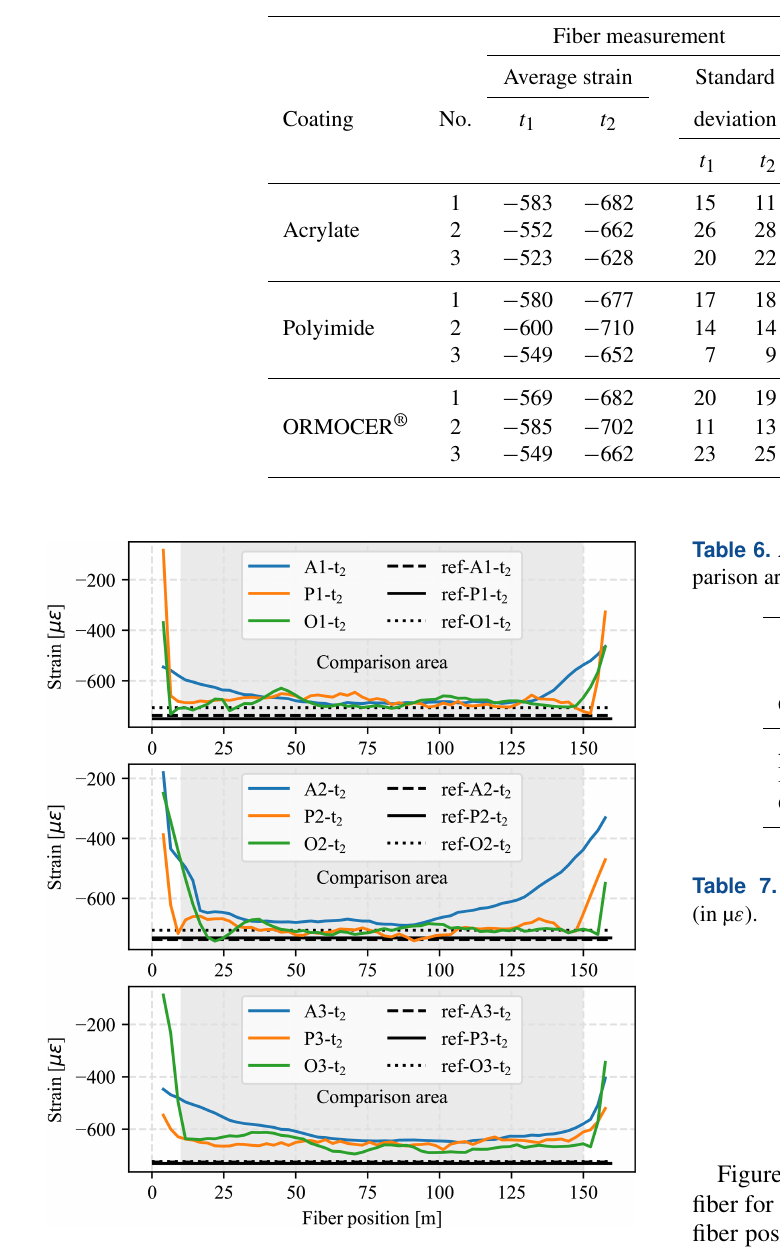
Figure 8. Strain profiles of all specimens at test time t 2 .